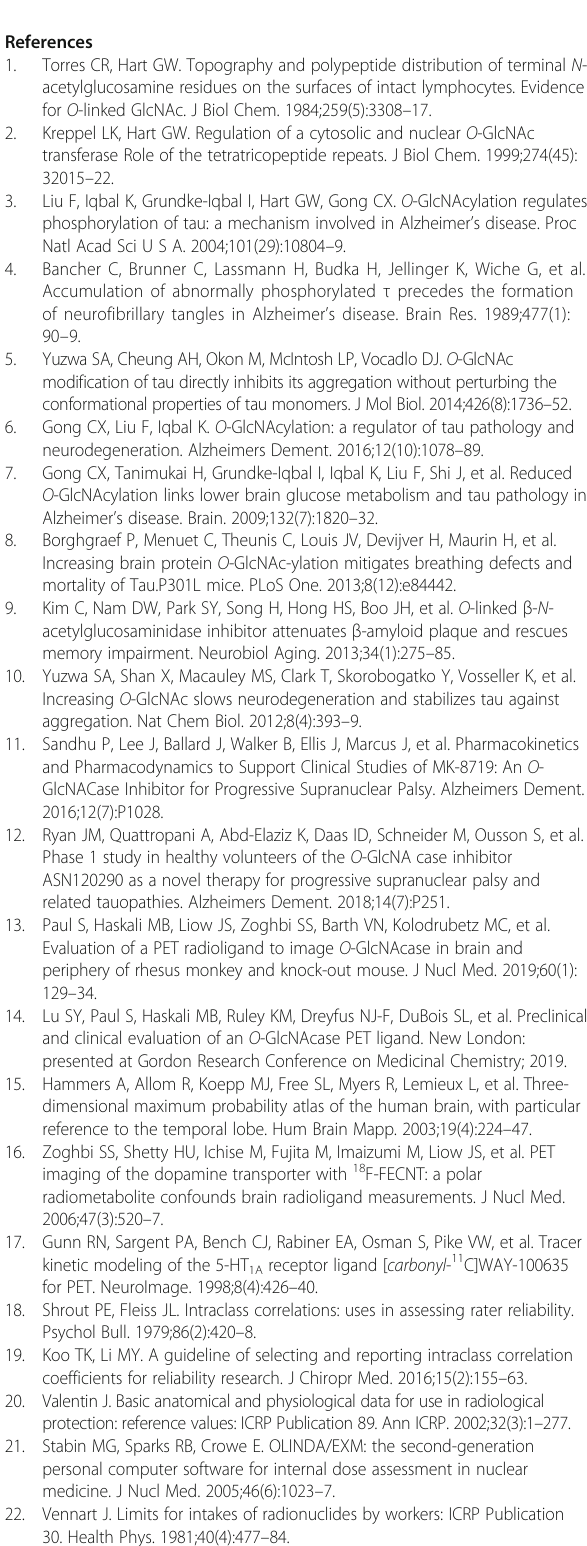
Additional file 3: Table S3. Radiation dose estimates from six healthy volunteers injected with [ 18